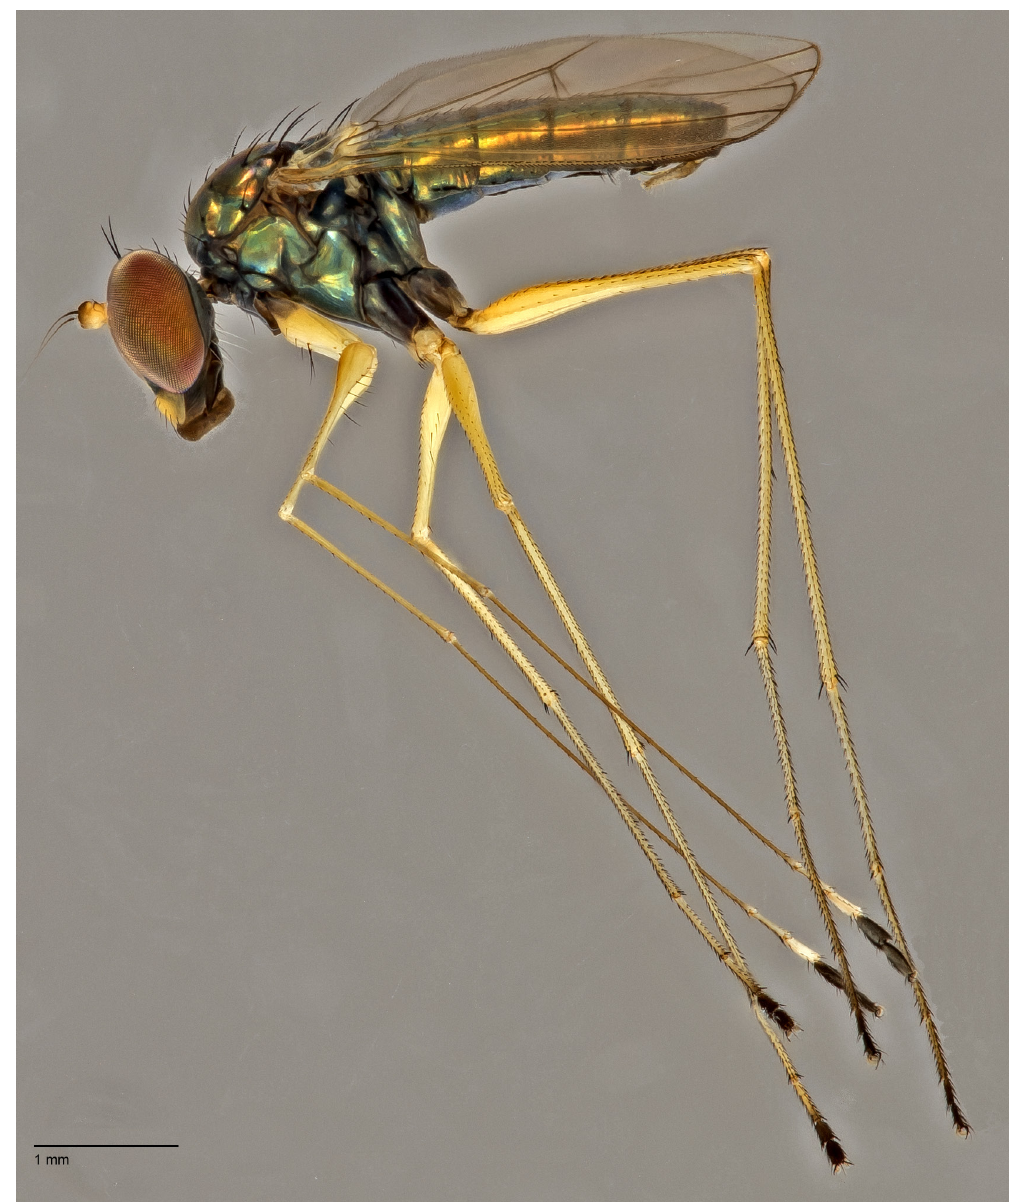
Fig. 25. Thinophilus spinatoides sp. nov., ♂,